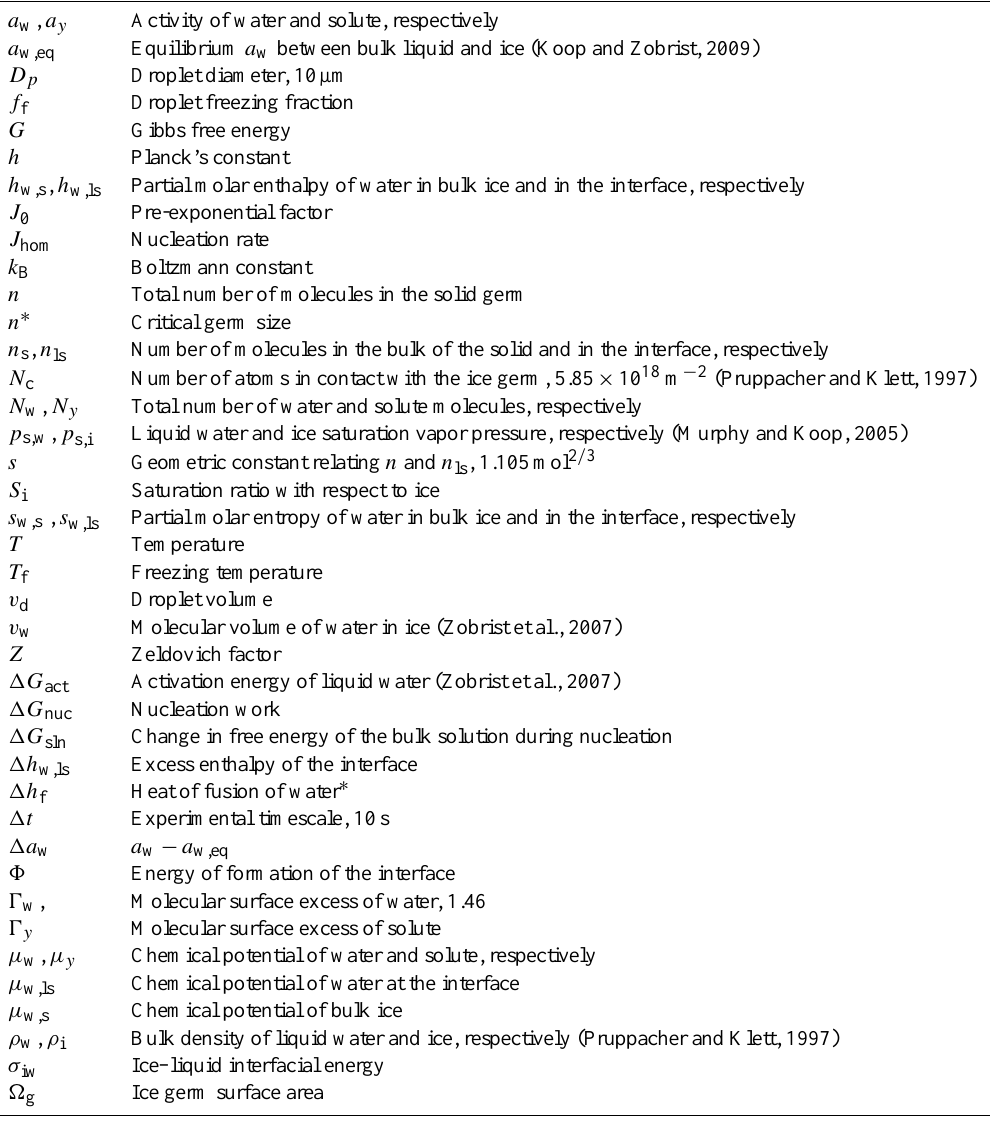
Table A1. List of